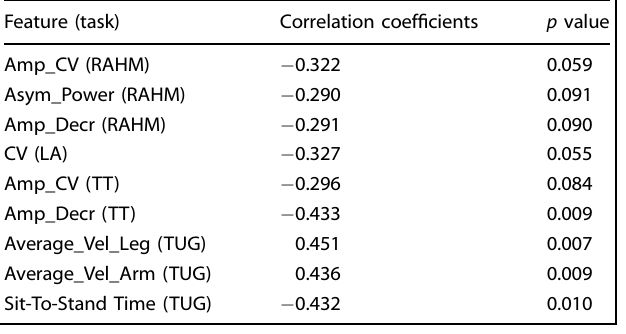
Table 3. Correlation coef fi cients for selected RAHM, LA, TT, and TUG features at T0 with MDS-UPDRS III score variation between baseline and last follow-up (T0 and T3). Feature (task)